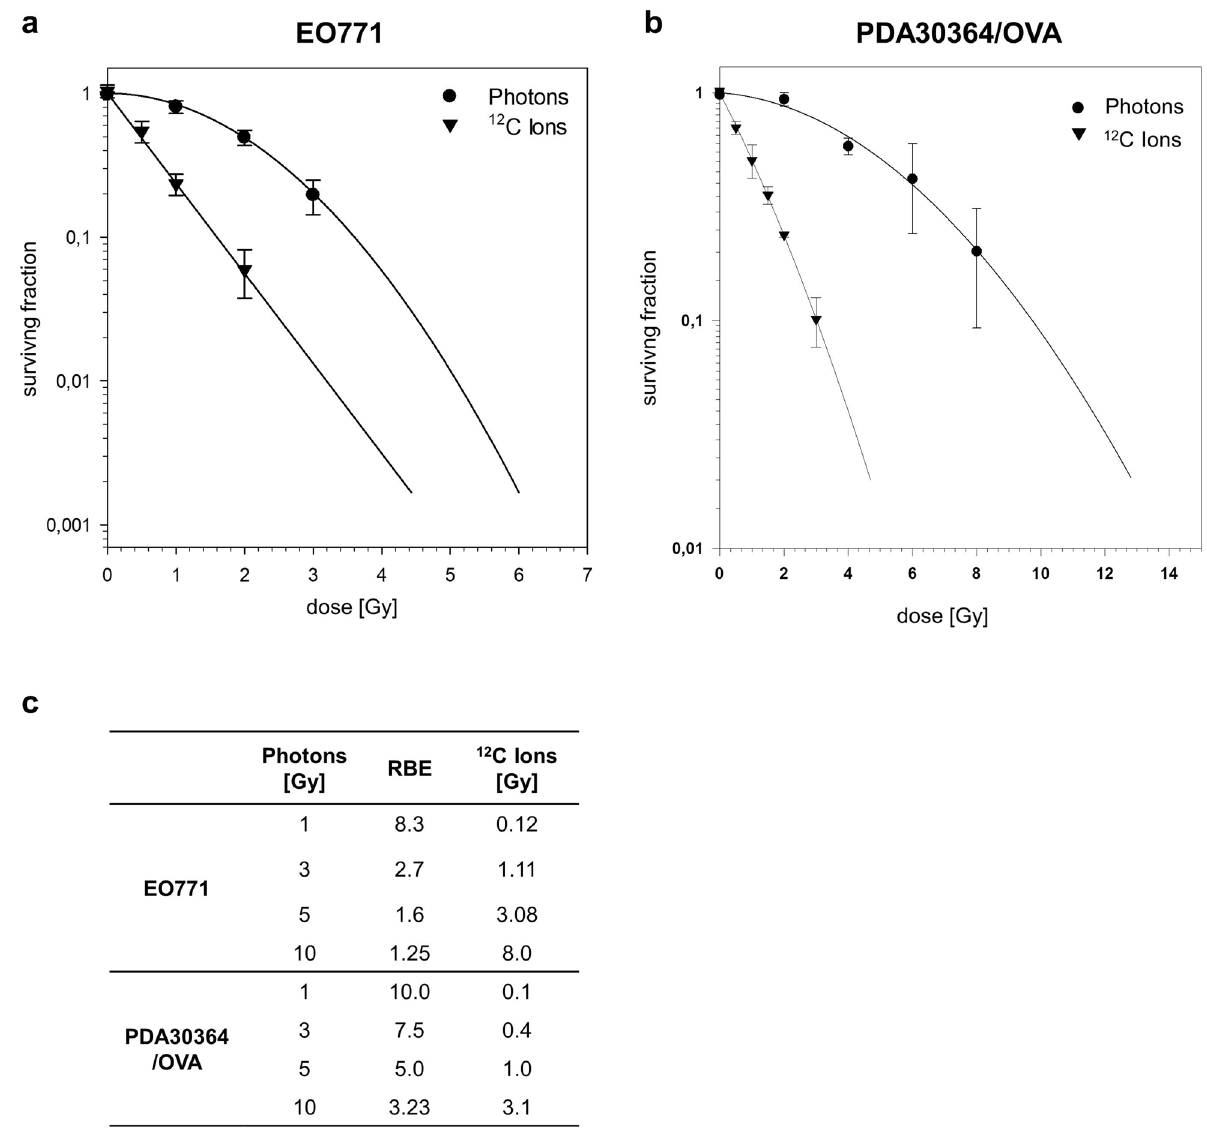
Figure 1. Radiation survival curves and RBE calculation for EO771 and PDA30364/OVA cells in response to photon or carbon ion irradiation. Clonogenic survival assays applying graded doses of photon or carbon ion irradiation to EO771 cells ( a ) and PDA30364/OVA cells ( b ). Mean values ± SD of triplicates from one (EO771) or two (PDA30364/OVA) independent experiments are shown. Physical doses of carbon ions biologically defined as equivalent to 1, 3, 5 and 10 Gy photon radiation applying dose-dependent RBEs are shown in ( c